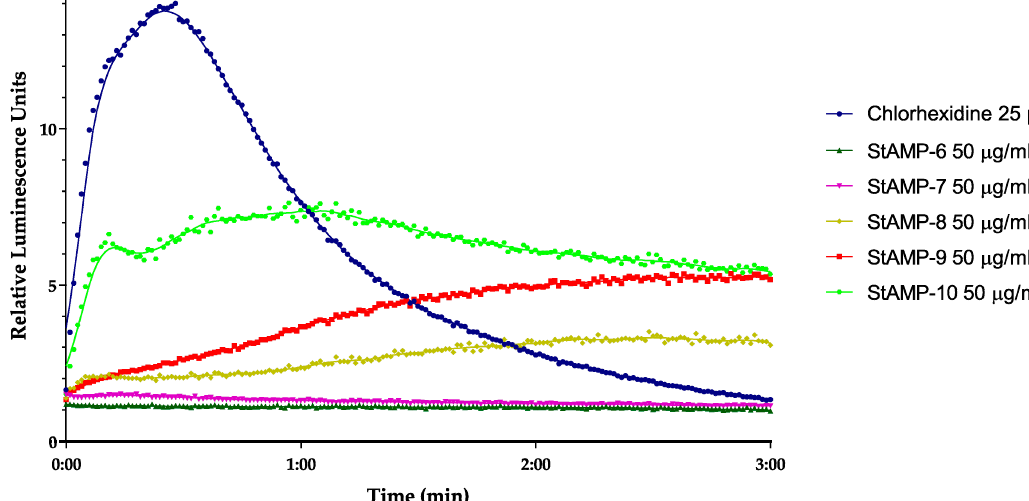
Figure 4. Kinetics of the antimicrobial effect on membrane integrity as measured by relative luminescence emission in E. coli K12 (pCSS962) in presence of D-luciferin. StAMP-6-10 and the reference antimicrobial agent chlorhexidine was added to the bacteria. Chlorhexidine and water were used as positive and negative control. Each datapoint is the mean of three independent measurements normalized to the water control.